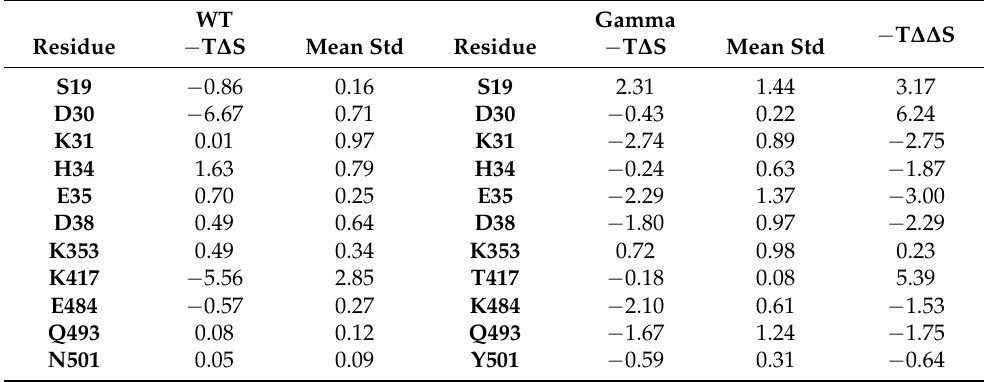
Table 3. Major residue contributions to the interaction entropy ( − T ∆ S). Main residues contributing to binding affinity changes. The interaction entropy is highlighted in red for the K417T, E484K and N501Y mutations. All values are in kcal/mol. Shaded cells correspond to hACE-2 residues.